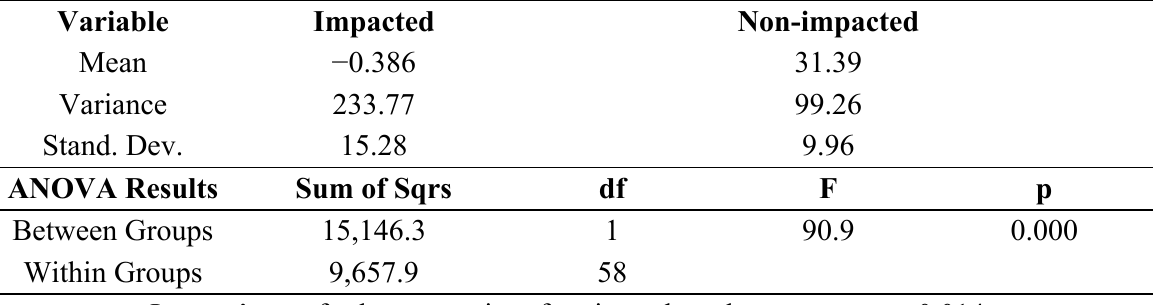
Table 3. ANOVA Results for Greenness